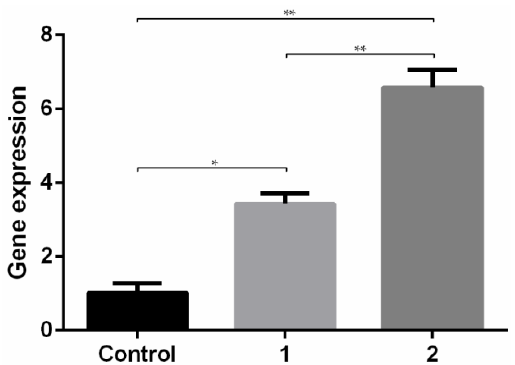
Figure 6. RT-qPCR of E7 expression levels in RAW cells. Control – non-transfected cells; 1 – CS-TPP- pDNA, centrifugation speed 6000 rpm, pDNA concentration of 60 μg/mL; 2– CS-TPP-pDNA, cen- centrifugation speed 6000 rpm, pDNA concentration of 60 µ g/mL; 2–CS-TPP-pDNA, centrifugation speed trifugation speed 10,000 rpm, pDNA concentration of 60 μg/mL. Data obtained from three inde- 10,000 rpm, pDNA concentration of 60 µ g/mL. Data obtained from three independent measurements pendent measurements (mean ± S.D., n = 3). * p < 0.05; ** p < 0.01. (mean ± S.D., n = 3). * p < 0.05; ** p <